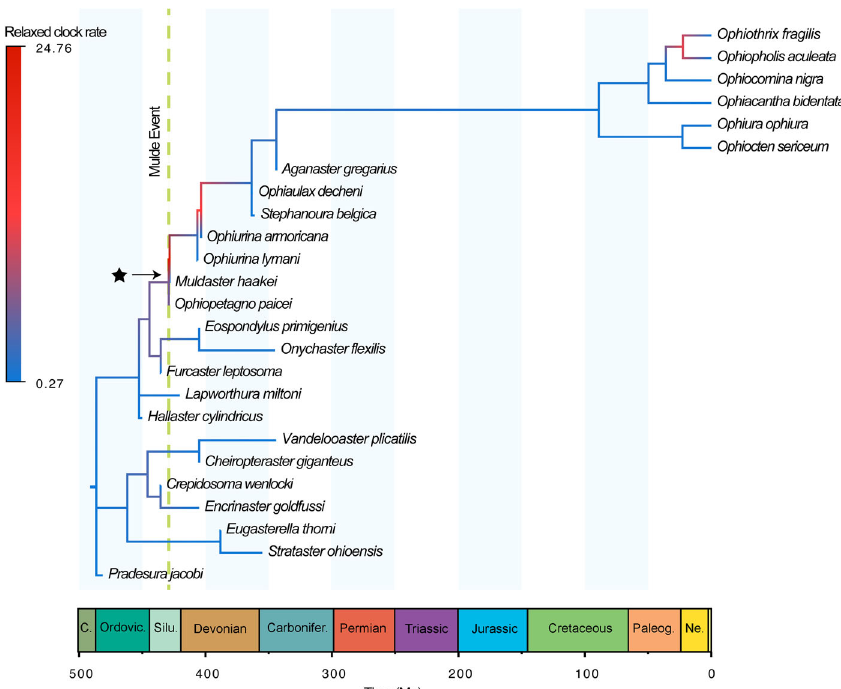
Fig. 3 Time-calibrated phylogeny from the tip-dating analysis with mean per-branch rates of discrete character evolution mapped to indicate low (blue colors) vs. high rates (red colors) of morphological evolution inferred from a model allowing each branch to have its own rate of change. The star indicates the branch with the highest rate in the tree (rate multiplier = 24.76), which links Ophiopetagno paicei and Muldaster haakei and occurs concomitant with the Mulde